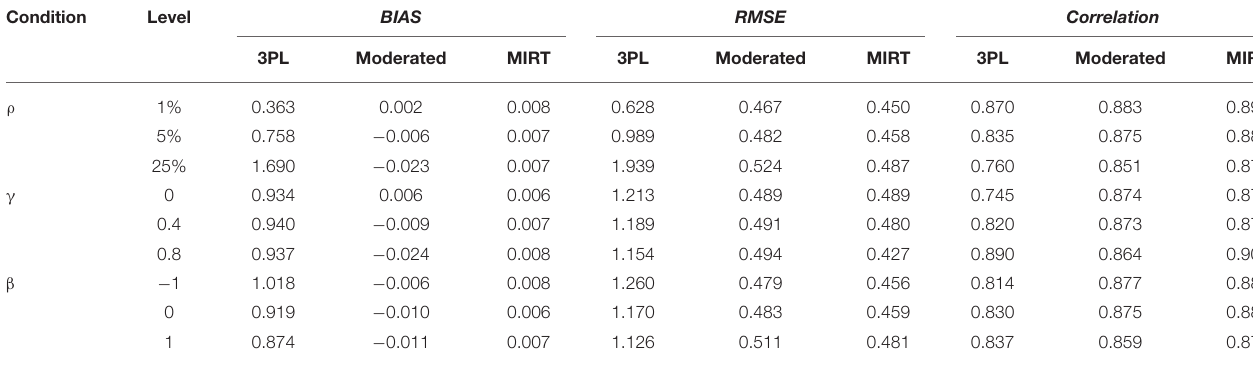
TABLE 4 | BIAS, RMSE and correlation for ability estimates in study II.